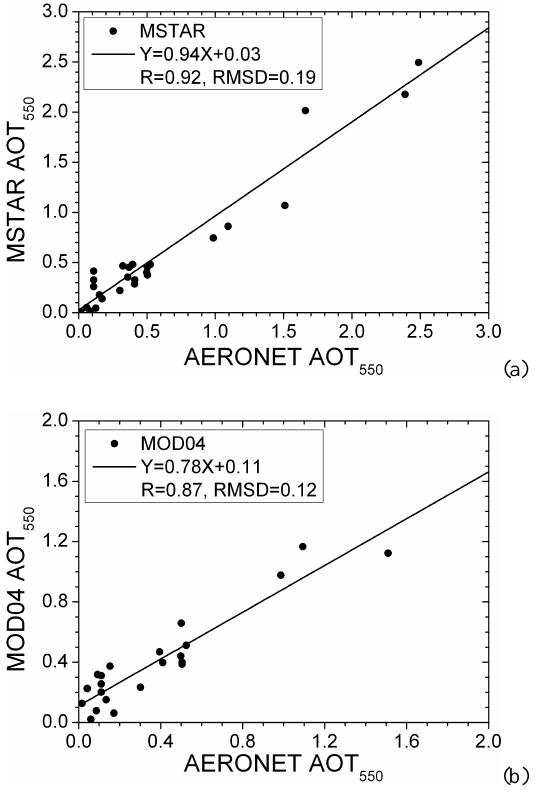
Fig. 10. Comparison of (a) MSTAR AOT and (b) MOD04 AOT with those measured by AERONET. Effective coincident data num- bers are 27 for MSTAR and 22 for MOD04.